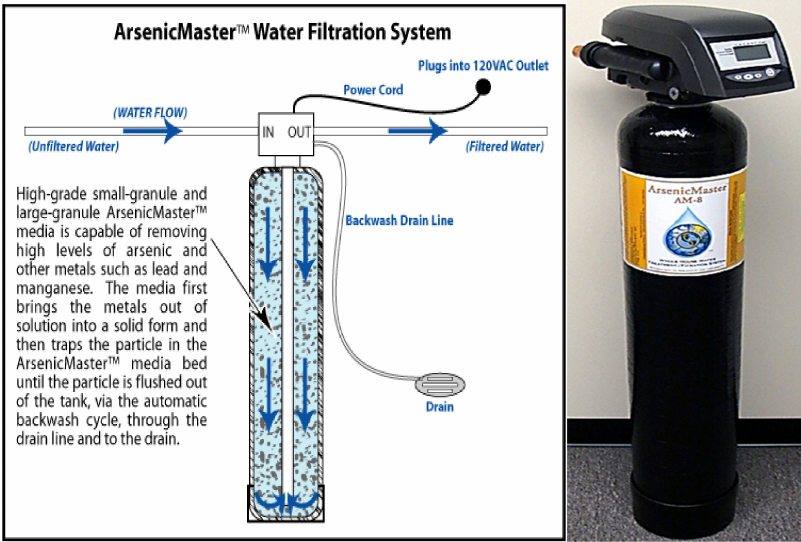
Figure 8. Components of the ArsenicMaster Whole House Arsenic Water Filtration System and a commercially available version [166]. Reproduced with